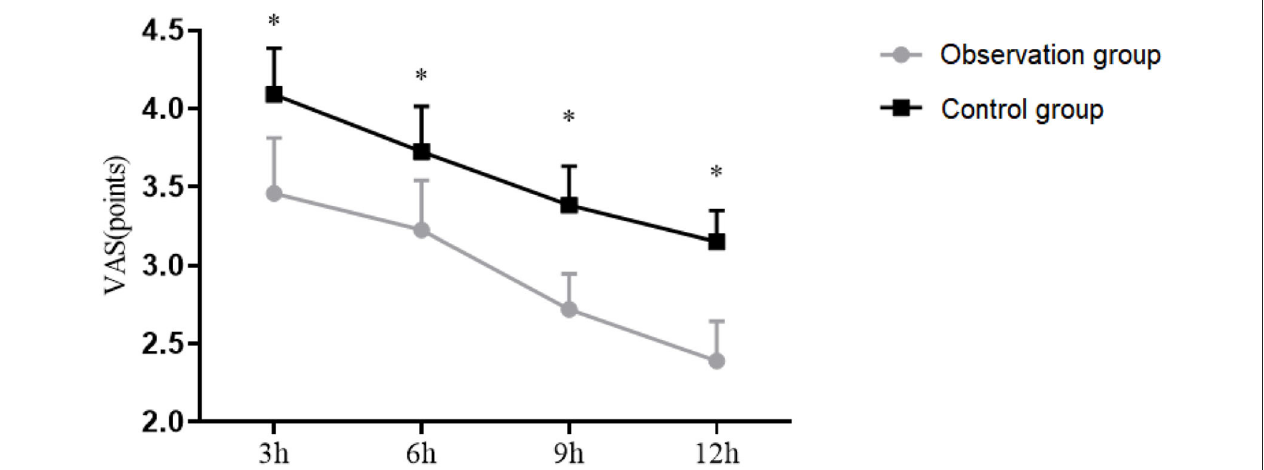
FIGURE 1 | Visual analog scale (VAS) scores of patients. The transverse axis was time after surgery (3, 6, 9, and 12h), and the vertical axis was VAS score. * P < 0.05.